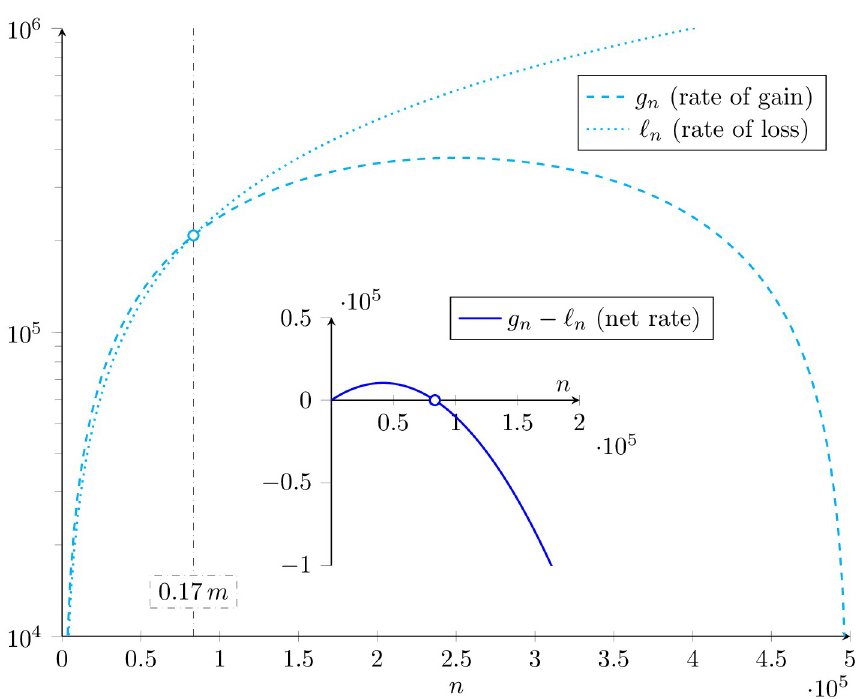
Fig 3. Rates of transposable element gain and loss in master equation model. Example rates of transposable element gain ( g , dashed) and loss ( ℓ , dotted) are shown cyan. These functions of TE load given by Eqs (18) and (19) intersect n n (balance) when 17% of the insertion sites are occupied (gray dot-dashed line). Parameters: η 0 = 20, η = 3, ν = 2.5, m = 5 × 10 5 . The net rate of change (blue curve) is zero for a TE load of n = 8.3 × 10 4 (open circle), which is on the order of that found for transposons (Class II elements) in Mimulus (e.g., LINE and LTR, see Fig 1B left).